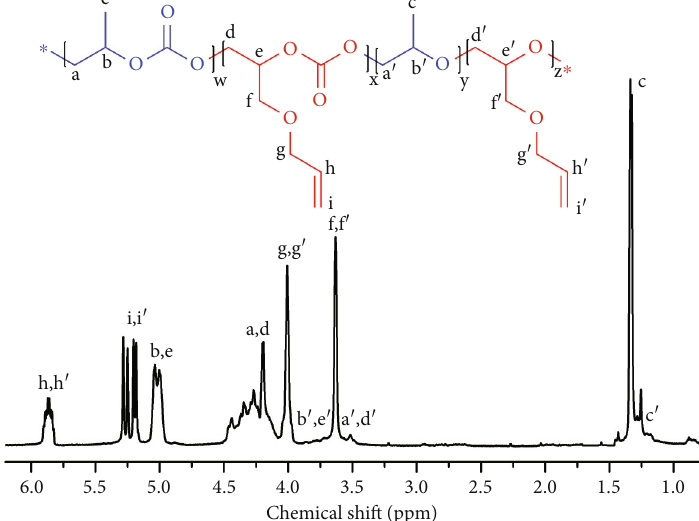
Figure 1: 1 H-NMR spectrum of terpolymer PPCAGE.